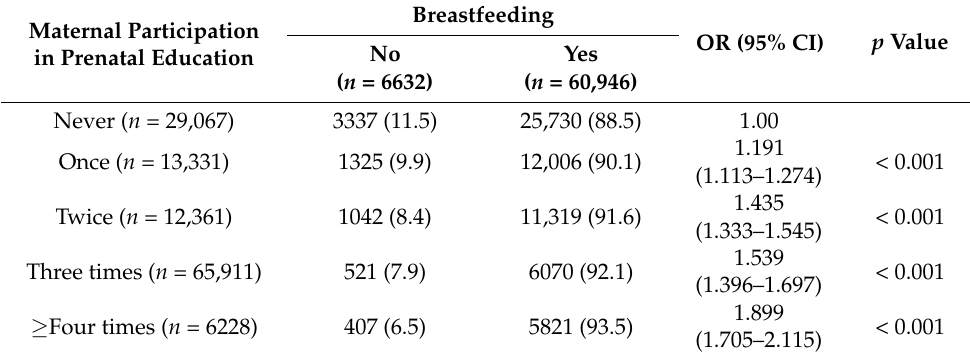
Table 4. Association between maternal participation in prenatal education and breastfeeding #